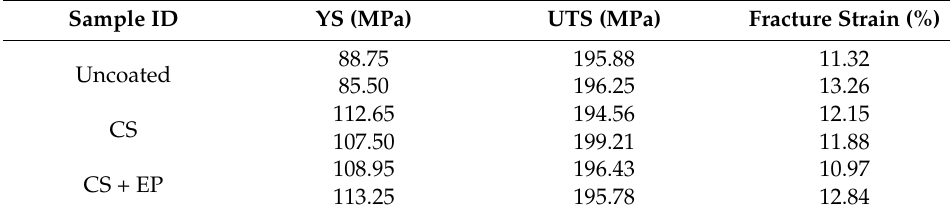
Table 5. Tensile properties of the uncoated, CS AA7075 coated, and CS + EP